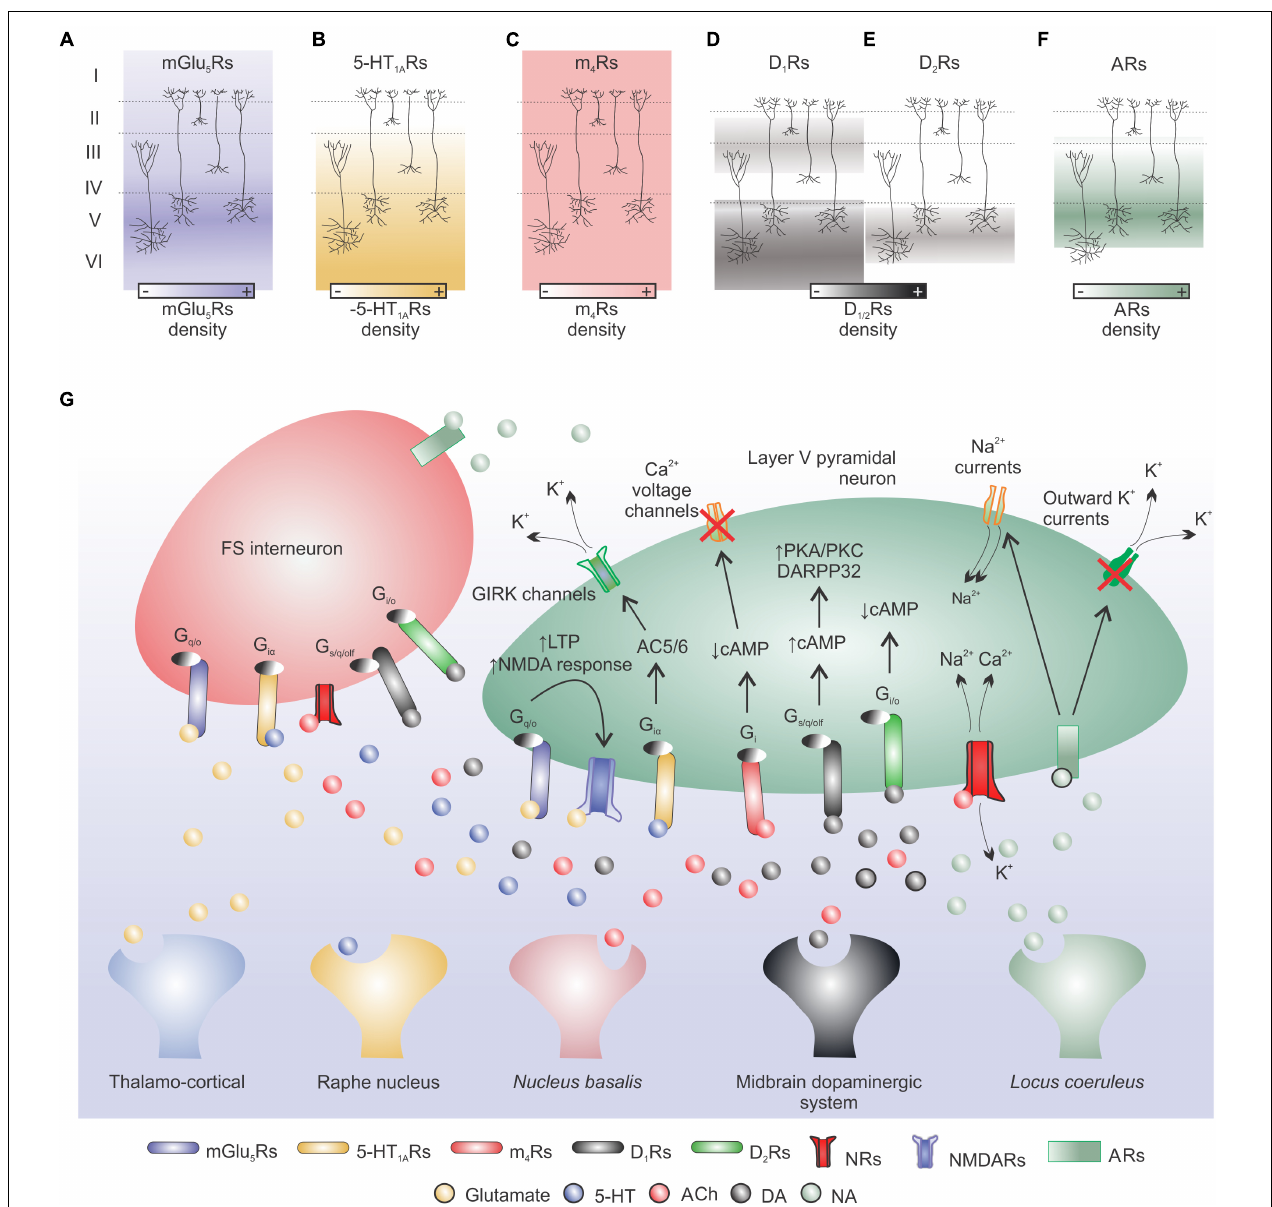
FIGURE 2 | Neuromodulation: main cortical neurotransmitter systems involved in motor learning. (A) Glutamate release from cortical or thalamic afferents can modulate cellular excitability and short/long-term plasticity in cortical pyramidal neurons. Metabotropic glutamate receptors (mGlu 5 Rs) are mainly expressed in cortical layer V and act via G q / O protein on downstream targets. This interaction can enhance NMDARs activity and induce LTP in pyramidal neurons. (B) Raphe nucleus serotonin (5-HT) can bind to 5-HT 1A Rs (high mRNA expression in cortical layers V and VI) and via a G i α protein-AC5/6 pathway induce K + efflux leading to cell hyperpolarization, both in pyramidal cells and FS interneurons. (C) Nucleus basalis acetylcholine (ACh) binds to muscarinic receptors (MRs; e.g., m 4 Rs) or nicotinic receptors (NRs). m 4 Rs are expressed in all cortical layers and are coupled to G i proteins that can reduce cellular activity through cAMP signaling. NMDARs are permeable to Na + , K + , and Ca 2 + ions and are modulated by intra- and extra-Ca 2 + concentrations (not shown). (D,E) Dopamine (DA) released by the midbrain dopaminergic system can bind to D 1 Rs (low expression in layers II–III and high expression in layers V–VI) or D 2 Rs (expressed in layer V but at a lower extent when compared to D 1 expression) and increase or decrease cellular excitability, respectively, via cAMP acting on downstream targets (e.g., DARPP32). (F) Locus coeruleus noradrenaline (NA) released to the cerebral cortex binds to adrenoceptors (ARs) highly expressed in cortical layers IV and V. NA may increase cortical excitability via a reduction of outward K + currents and increase of Na + currents. (G) Simplified model of cortical neurotransmitter systems involved in motor learning.